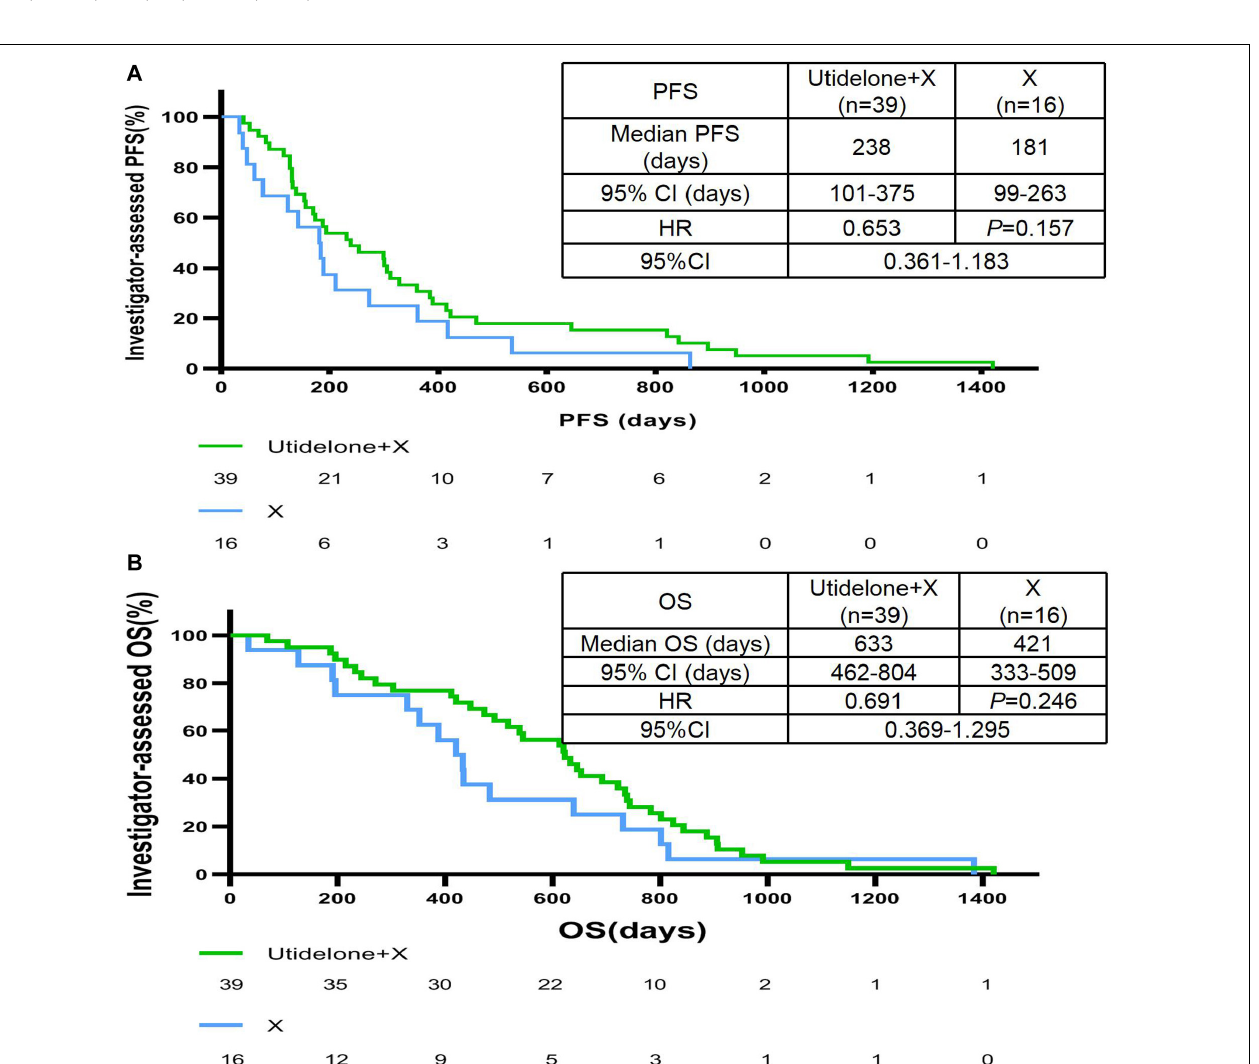
Frontiers in Oncology |